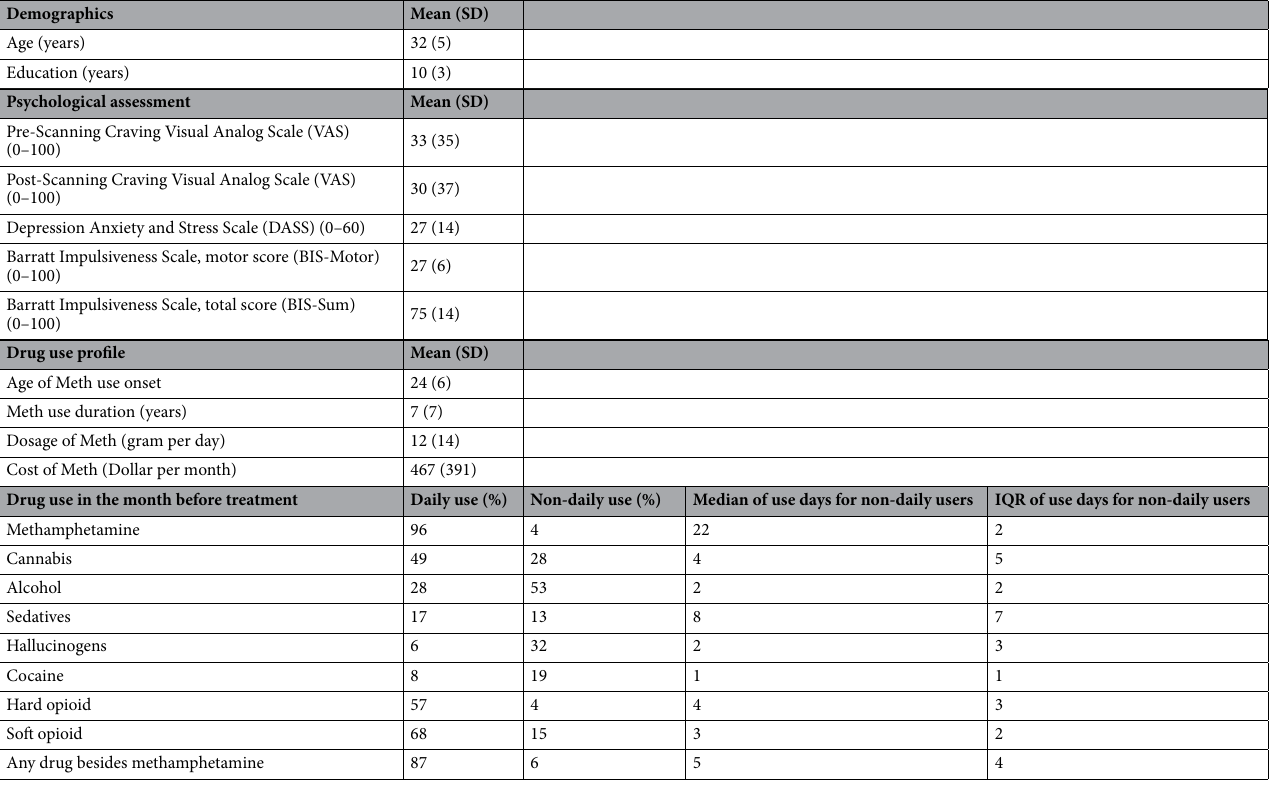
Table 1. Demographic and the profile of male Methamphetamine users (n = 53). Most values are reported as mean (standard deviation). Proportions of daily users (those reporting the use of a substance on every day of the month before entering treatment) and non-daily users (those reporting the use of a substance during the month before treatment, but did not use it on a daily basis) are presented as percentages. For non-daily users, medians and interquartile ranges (IQR) of numbers of use days are provided (for daily users, the median would be 30 and IQR would be